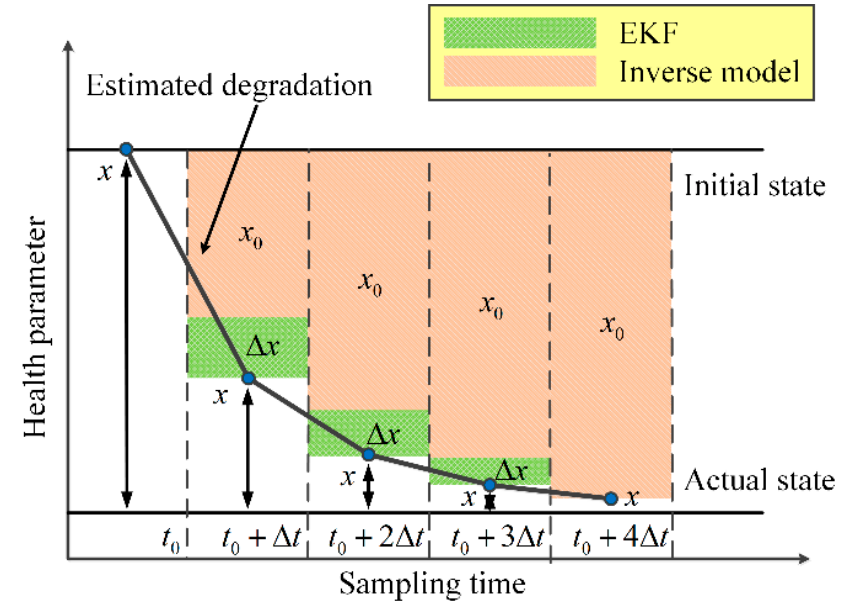
Figure 7. The distribution diagram of estimated degradation.